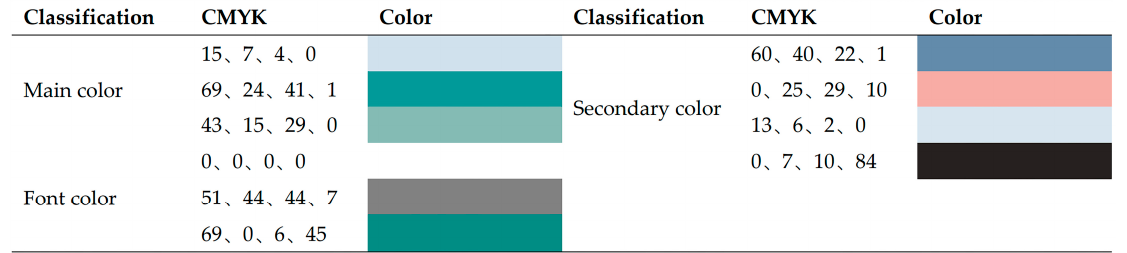
Figure 6. The system of metaphorical color.